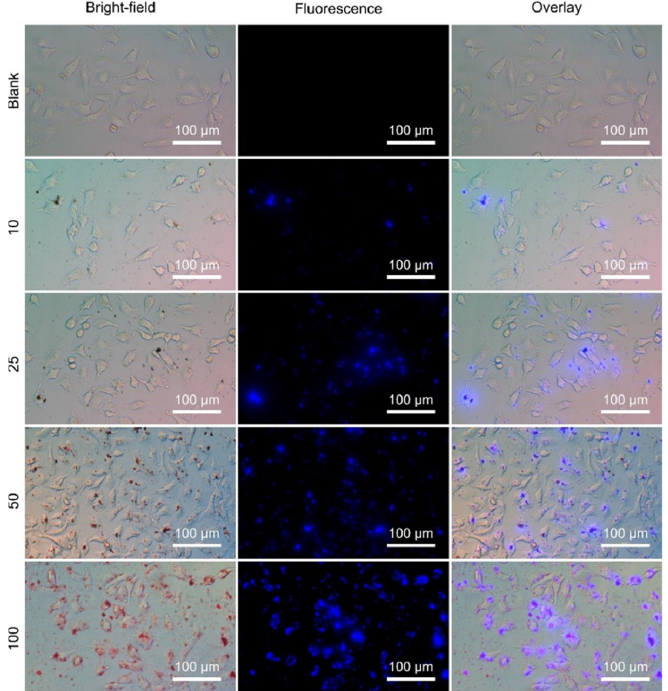
Figure 9. Confocal images of A549 cells incubated with OCNQDs (0 μ g/mL, 10 μ g/mL, 25 μ g/mL, 50 μ g/mL, and 100 μ g/mL) for 2 h at 37